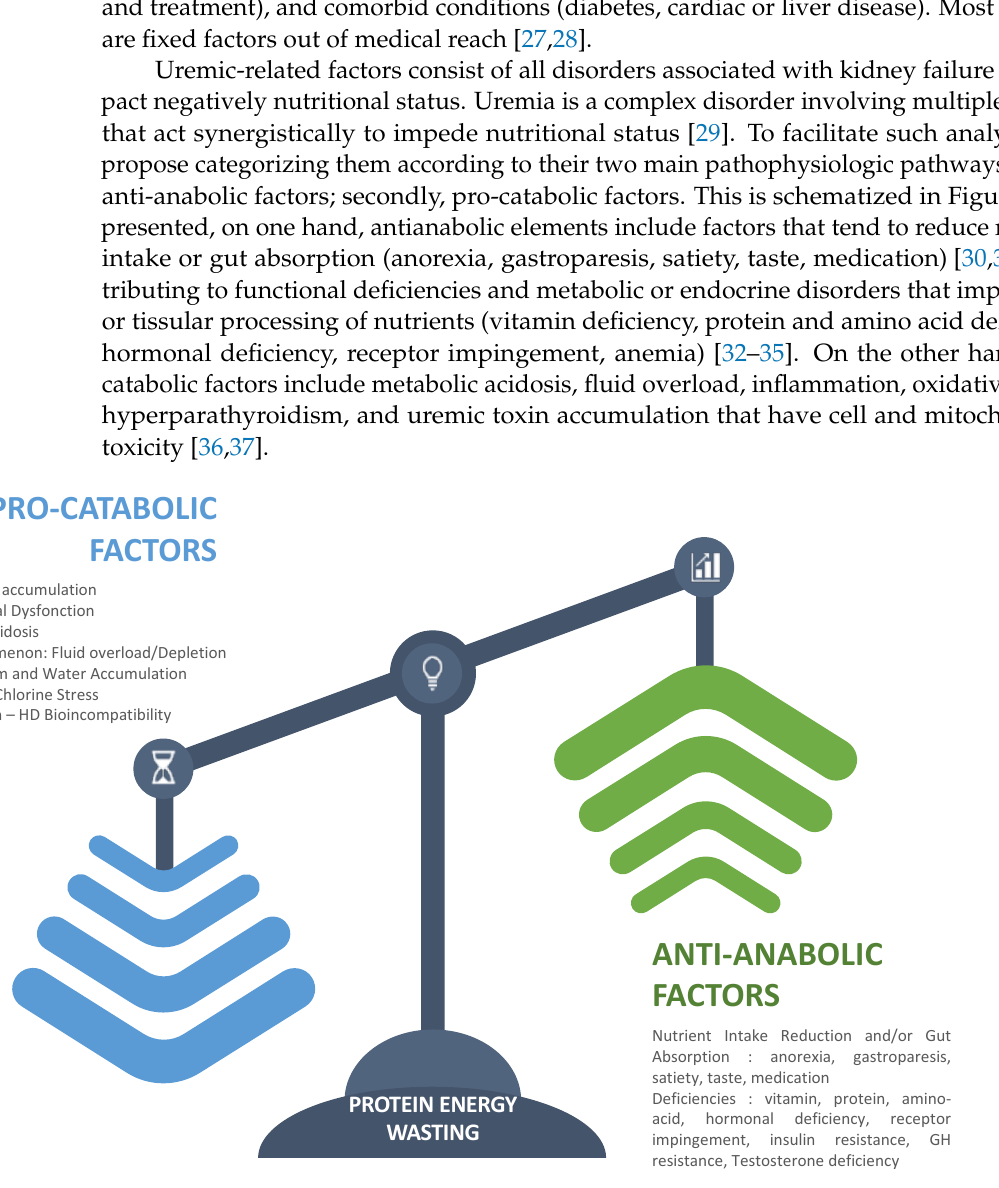
Figure 2. Clustering factors that favor the protein – energy-wasting process. Dialysis-related factors are superimposed conditions to uremia with dual and oppo- site action. On one hand, hemodialysis has a positive action by controlling uremic disor- ders and restoring internal milieu homeostasis through periodic reduction of nitrogenous waste products and correction of electrolytic and fluid volume imbalance. On the other hand, hemodialysis has a negative action by creating unphysiological cyclic shifts and by triggering directly protein muscle degradation to compensate for amino acid, peptides, and nutrient losses [38]. Dialysis-induced nutritional stress tends also to reorientate liver protein synthesis toward acute phase proteins at the expense of albumin synthesis [39].